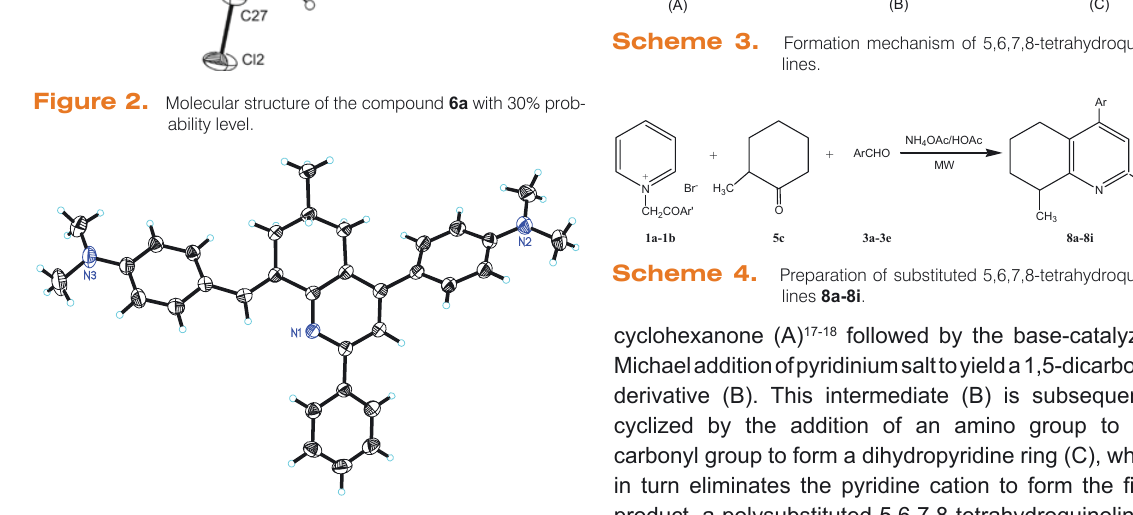
Figure 3. Molecular structure of the compound 6d with 30% prob- ability